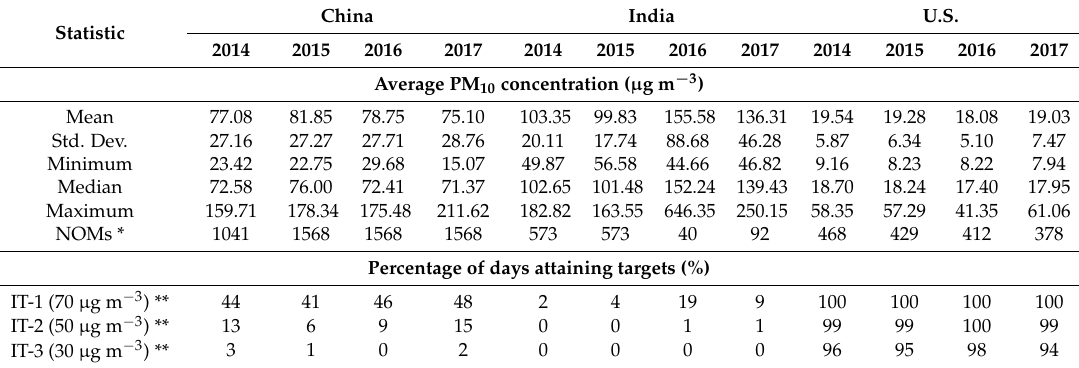
Table 2. Summary of daily PM 10 concentrations in China, India, and the